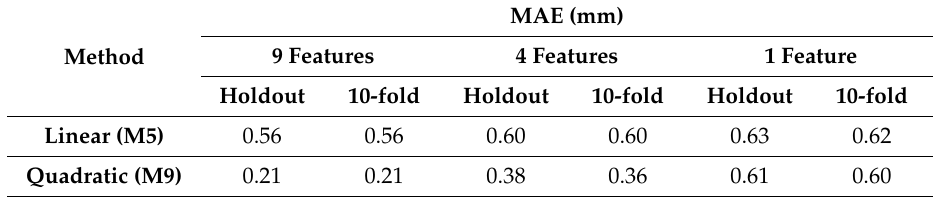
Table 2. MAE for simple linear and quadratic models with a di ff erent number of